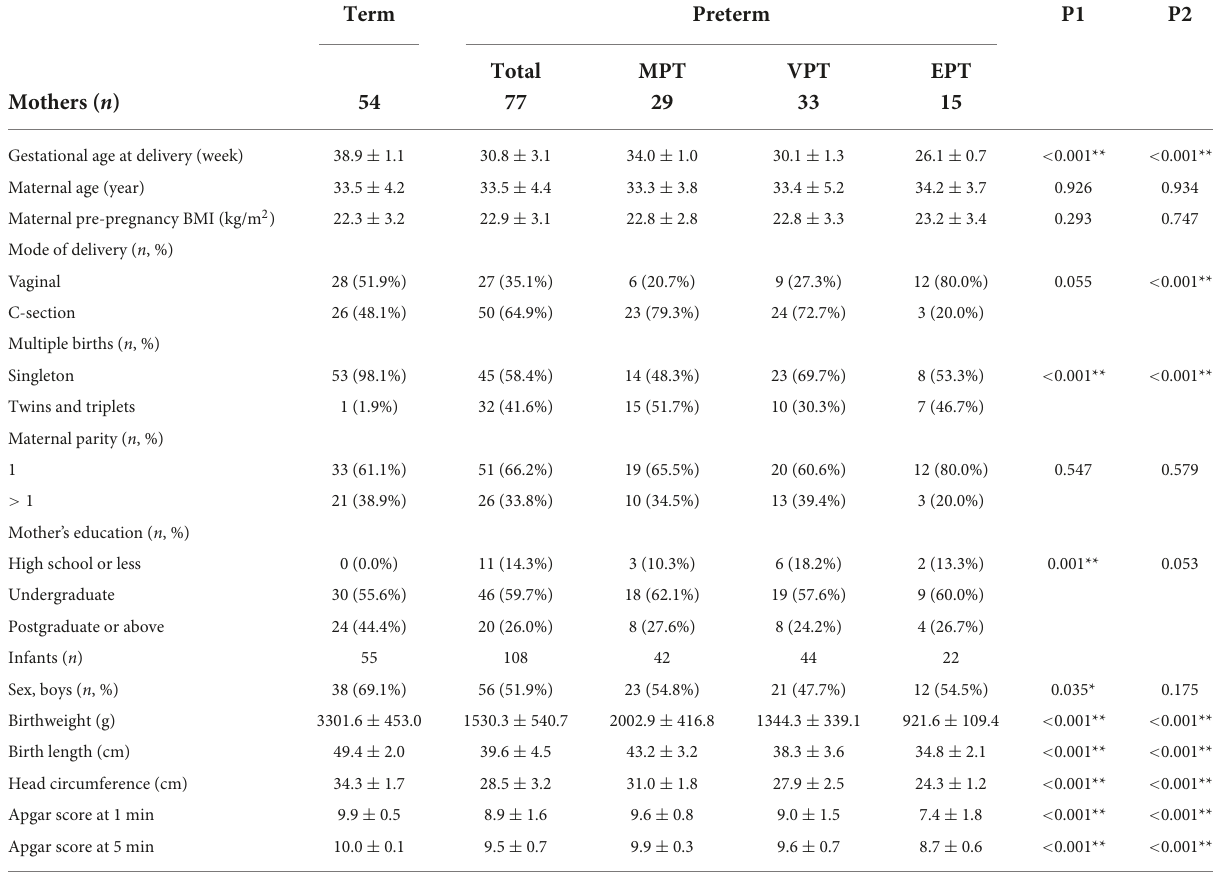
TABLE 1 Baseline characteristics of the mothers and